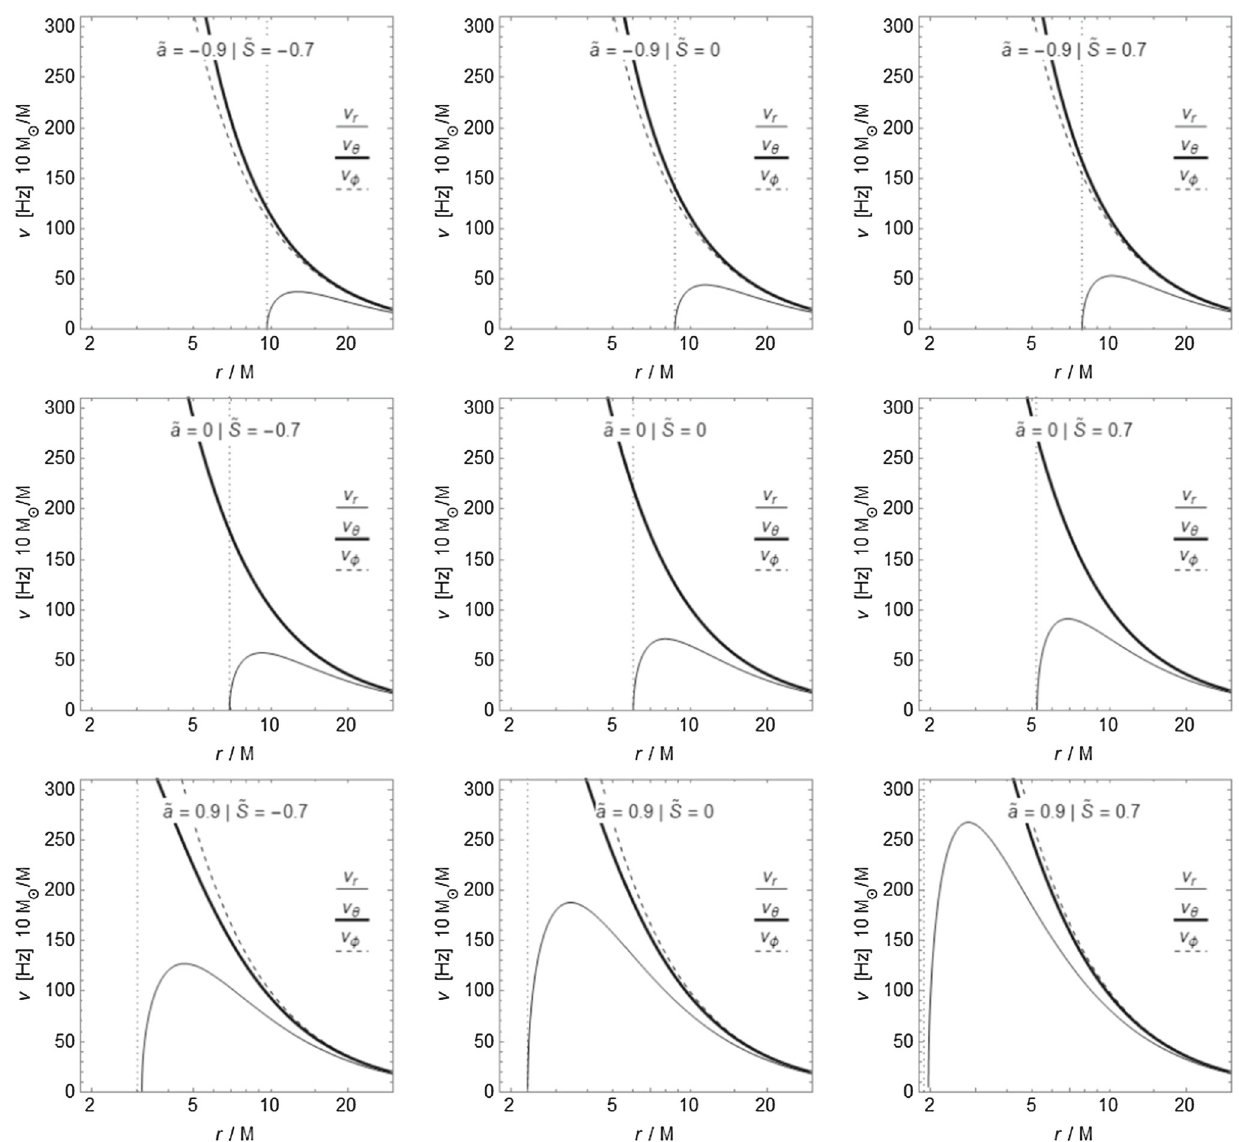
Fig. 2 Radial profiles of frequencies of small harmonic oscillations ν r , ν θ and ν φ of neutral spinning test particles in the background of Kerr BH having mass M = 10 M (cid:5) measured by a static distant observer. The dotted lines represent the ISCO